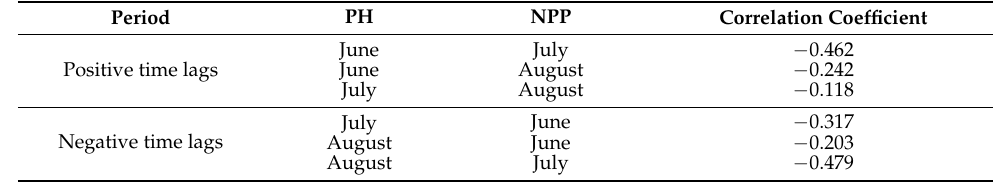
Table 4. Time-lag correlation of pH and NPP in summer during